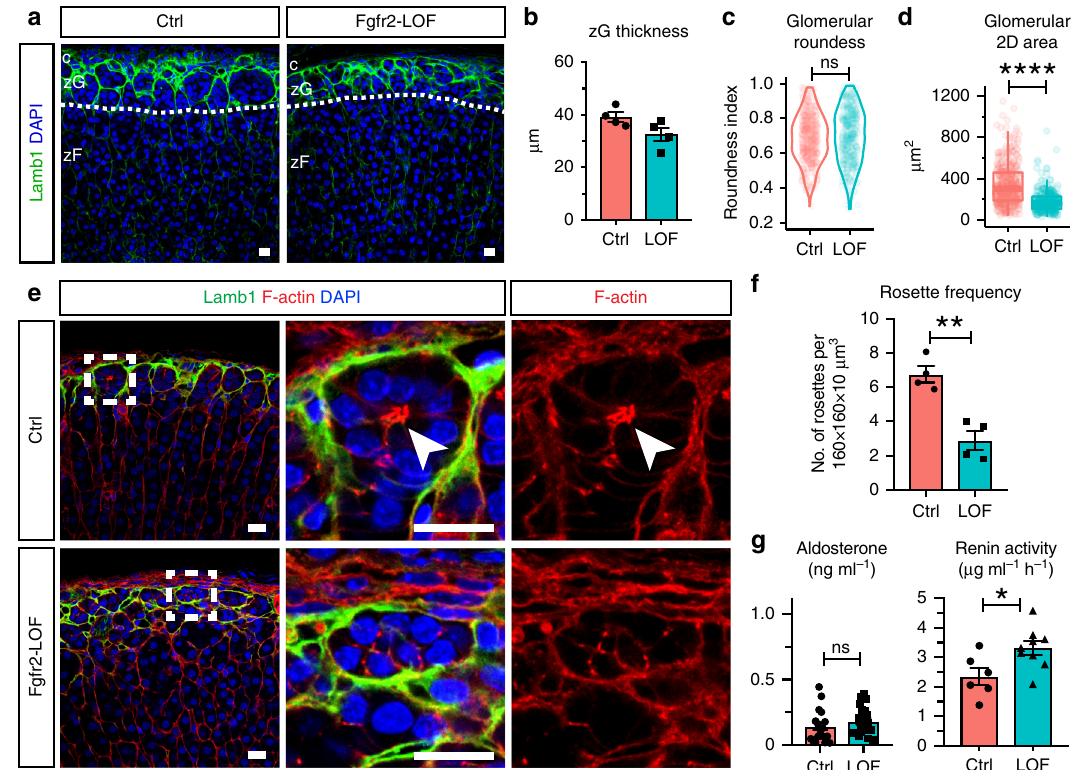
Fig. 7 Fgfr2 deletion disrupts rosette morphology and zG physiological function. a Lamb1 staining (green) shows disrupted glomerular morphology in Fgfr2 loss-of-function (LOF) adrenals compared to controls (Ctrl). DAPI marks nuclei (blue). Dotted line demarcates the zG/zF boundary. c, capsule; zG, zona glomerulosa; zF, zona fasciculata. b Measurement of zG thickness. N = 4, 4 mice. c , d Measurement of glomerular roundness and cross-sectional area. Mann – Whitney ’ s nonparametric test, ns not signi fi cant, **** P < 0.0001. For c and d , four animals from each group (2 males and 2 females) and at least 30 glomeruli per animal were examined. e F-actin staining (red) reveals loss of rosette structures in the glomeruli of Fgfr2-LOF adrenals. Glomerular boundary is outlined by Lamb1 (green). Boxed areas are shown in higher magni fi cation on the right. Arrowheads point to rosette center. DAPI marks nuclei (blue). f Rosette frequency calculated as rosette number per 160 × 160 × 10 μ m 3 z-stack cortical area. Student ’ s t test, ** P < 0.01, N = 4, 4 mice. For each animal, data from three different cortical areas were averaged. g Plasma aldosterone level ( N = 18, 21 mice) and plasma renin activity ( N = 6, 9 mice) in Ctrl and LOF mice. Mann – Whitney ’ s nonparametric test, ns not signi fi cant; * P < 0.05. All bars, 10 μ m. In all bar plots, error bars represent SEM. In all box plots, box boundaries represent the 25th and 75th percentiles, whiskers represent the 5th and 95th percentiles, center lines represent median. Source data are provided as a Source Data fi